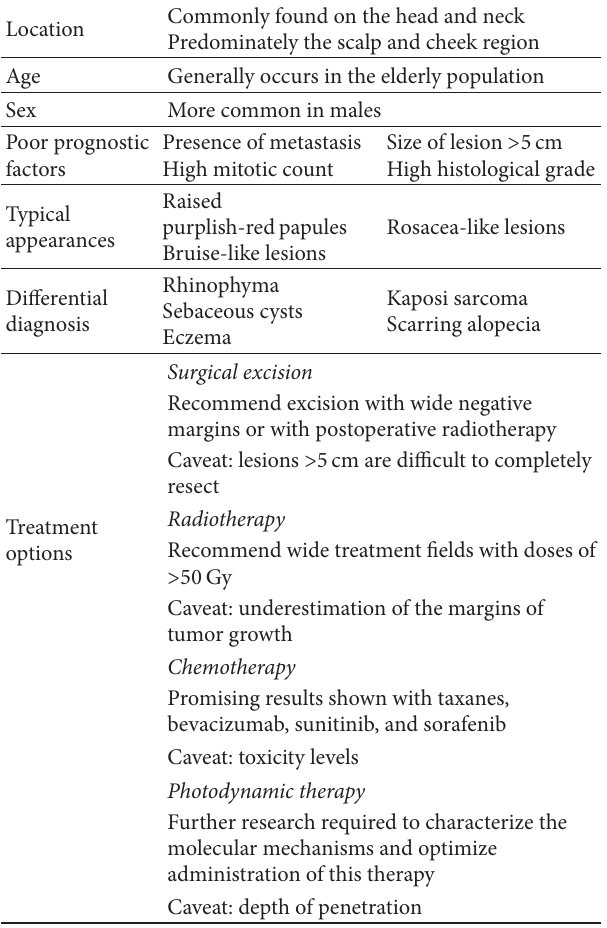
Table 1: Overview of cutaneous